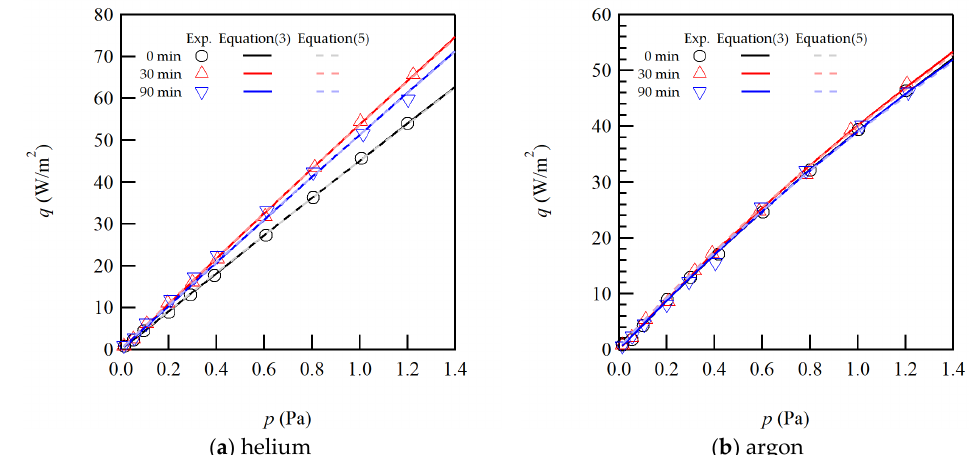
Figure 3. Typical results of the measured heat fluxes and the fitted curves as a function of pressure for 0 min, 30 min and 90 min sample surfaces for ( a ) helium and ( b ) argon.